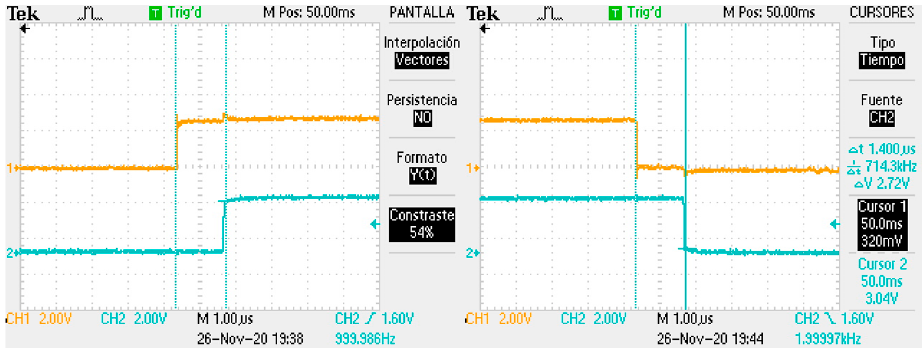
Figure 16. Advanced gate-driven signal for optimal MOSFET commutation.